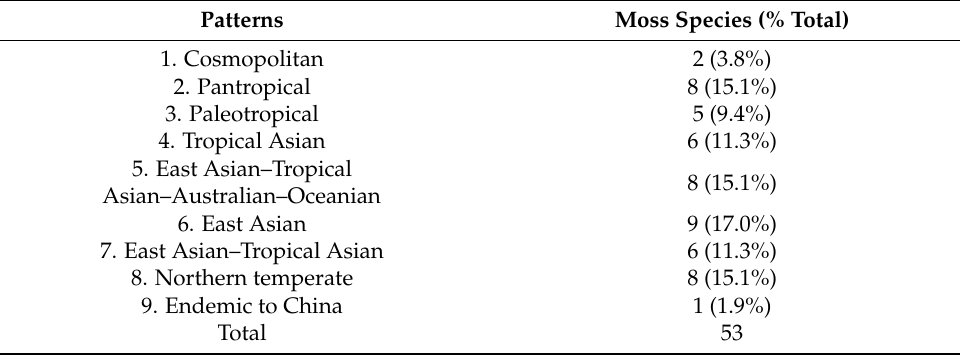
Table A3. Phytogeographical elements of terrestrial mosses on Tai Mo Shan.